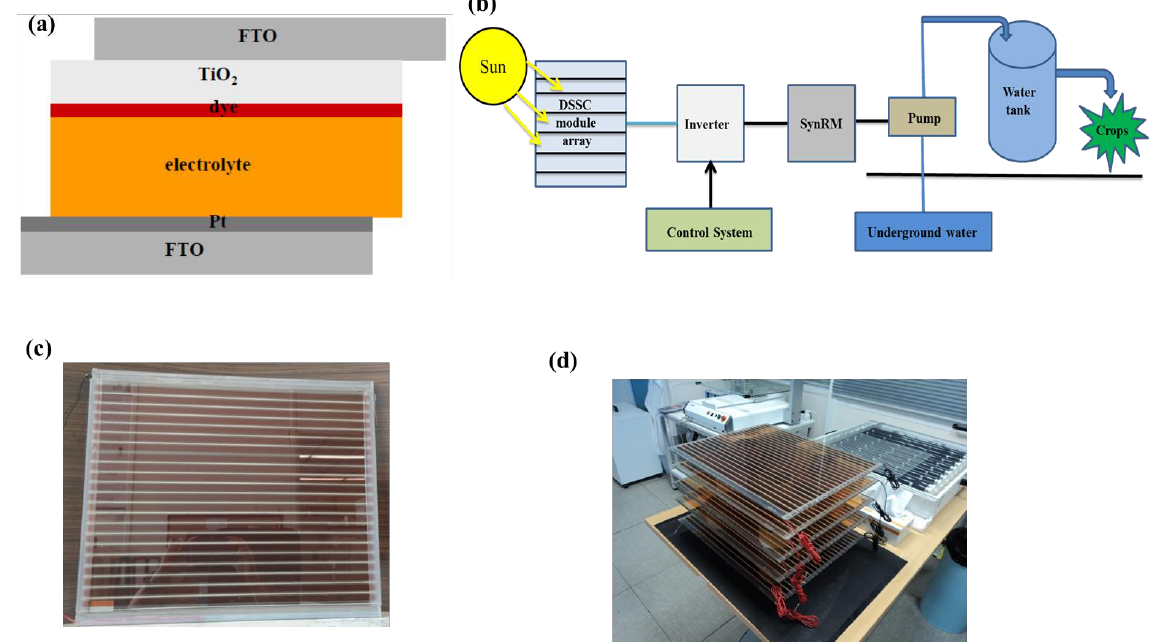
Figure 1. DSSC structure: FTO/TiO2/dye/electrolyte/Pt/FTO (FTO: fluorine-doped tin oxide on glass) ( a ); schematic representation of the water-pumping system fed by a DSSC module array ( b ); DSCS module (40 × 47.5 cm) consisting of 22 unit cells (1 × 45 cm) connecting in series ( c ); and the package of modules employed for the construction of the DSSC array ( d ).